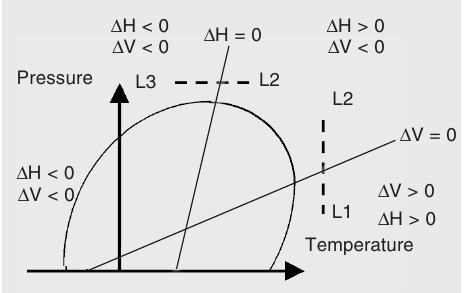
Figure 1. The elliptical tempera- ture-pressure stability phase dia- gram characteristic of proteins. Note the thermodynamic simi- larities between the cold and pressure unfolding and the con- trast with heat unfolding. The possible volume-driven (L1-L2) and enthalpy-driven (L2-L3) transitions are discussed in the text. Modified from Ref.